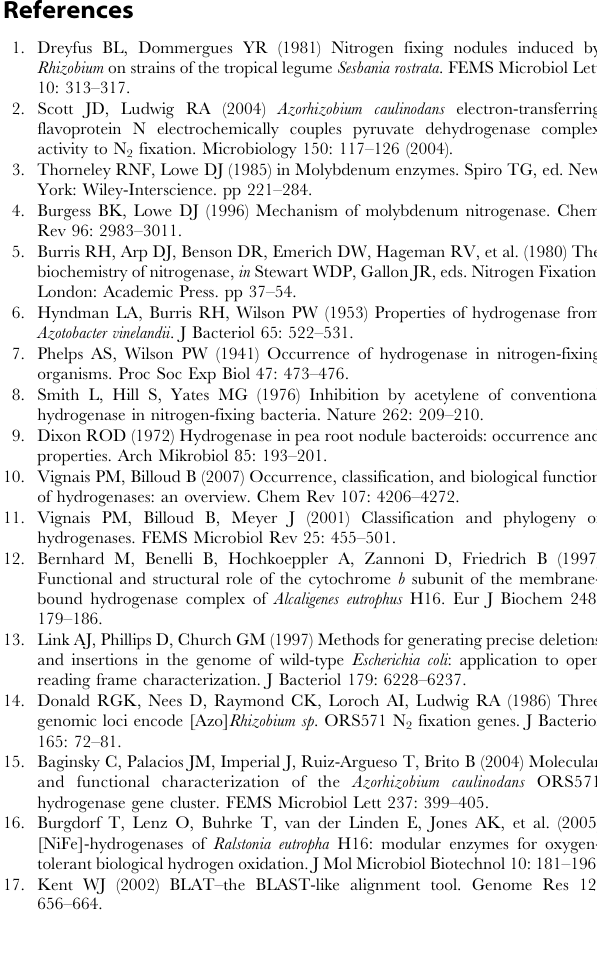
(Table 1) carrying both upstream hyqR::uidA + hyq D BI and downstream hyq + operon were identified and verified by PCR and DNA sequencing analyses. Physiological growth and b -glucuronidase